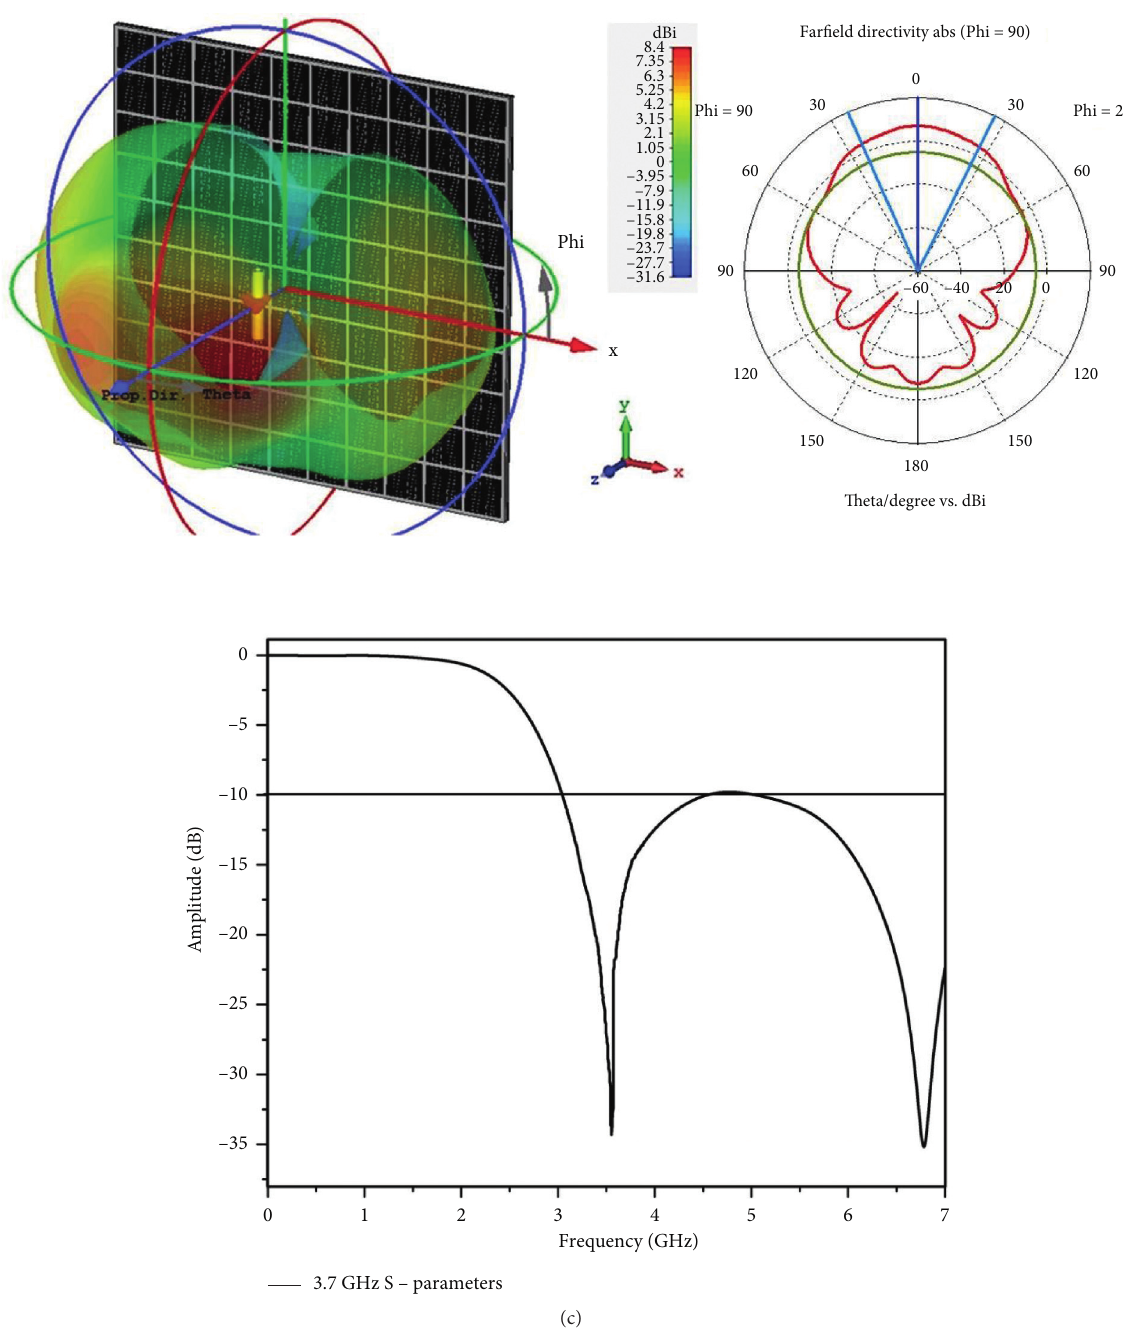
Figure 13: The simulation radiation pattern and insertion loss of dipole antenna within ICPW-EBG reflector: (a) 1.8GHz, (b) 2.45GHz, and (c)